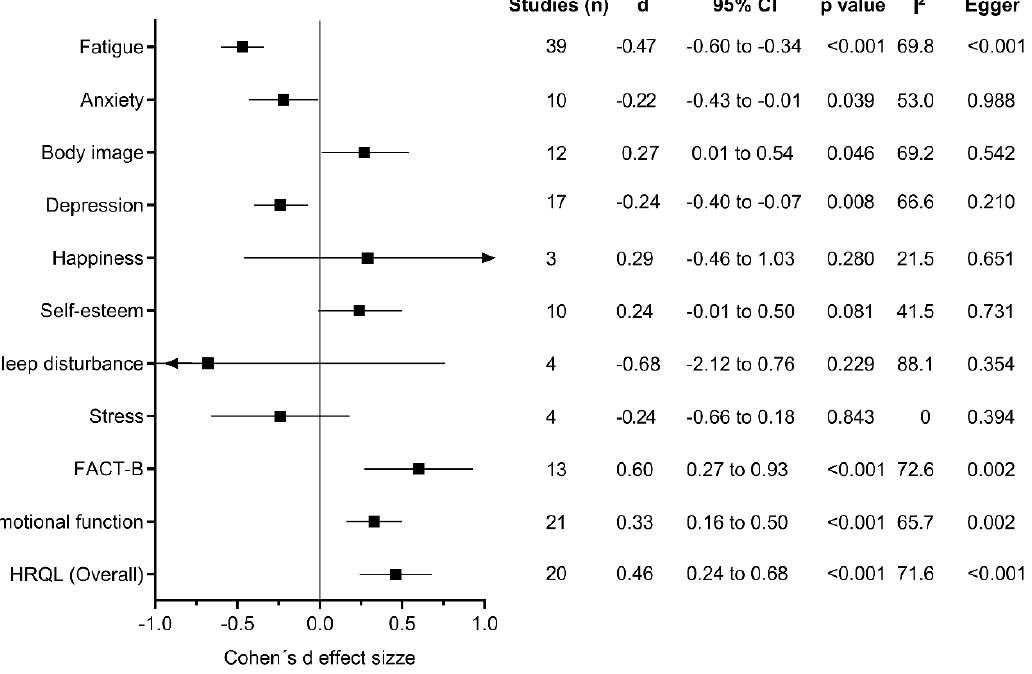
Figure 2. Exercise effects on mental health parameters.